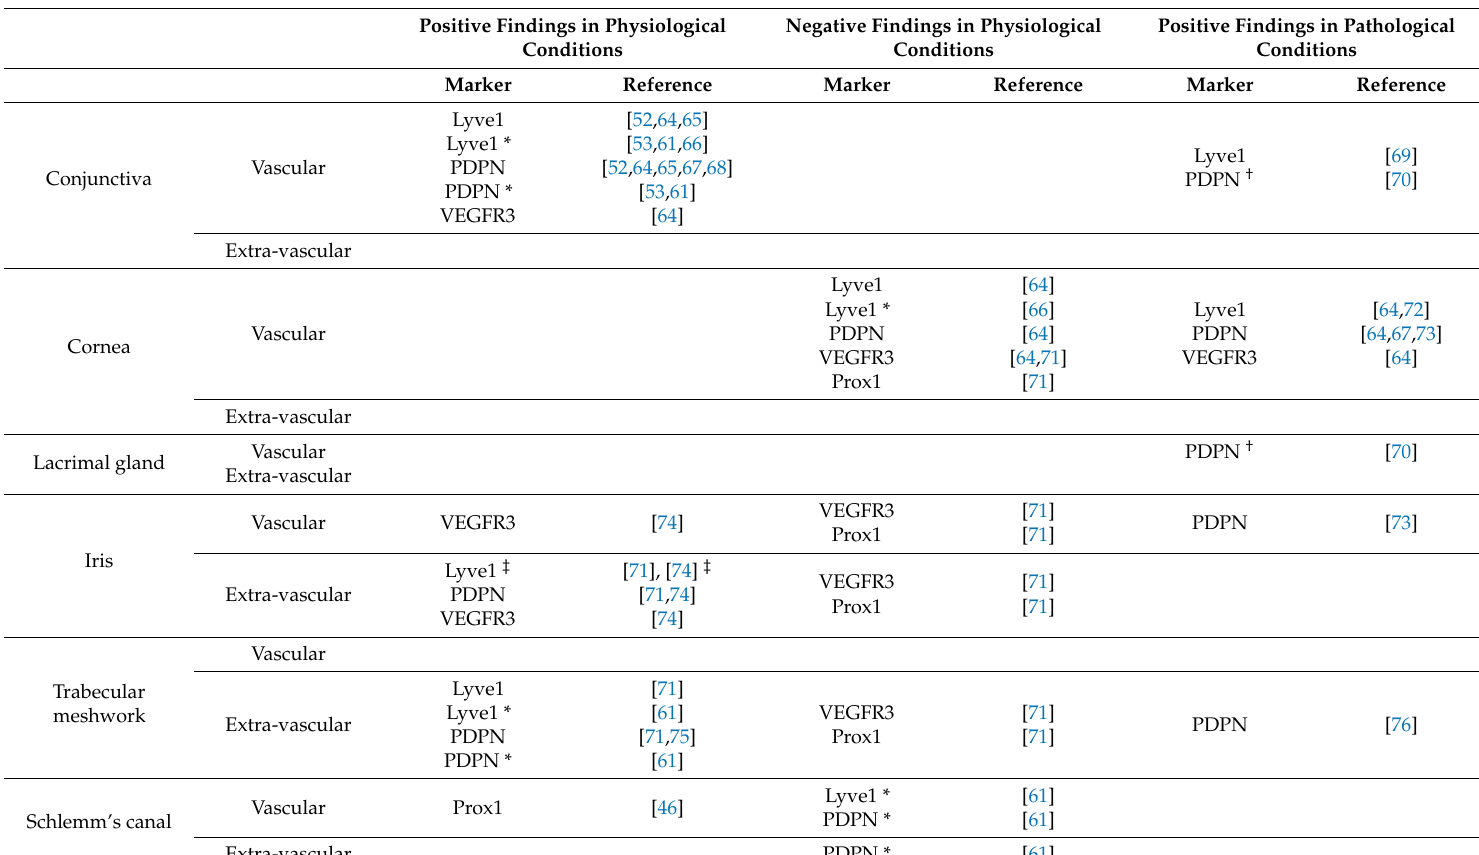
Table 1. Positive and negative findings on the existence of lymphatic vessels in ocular